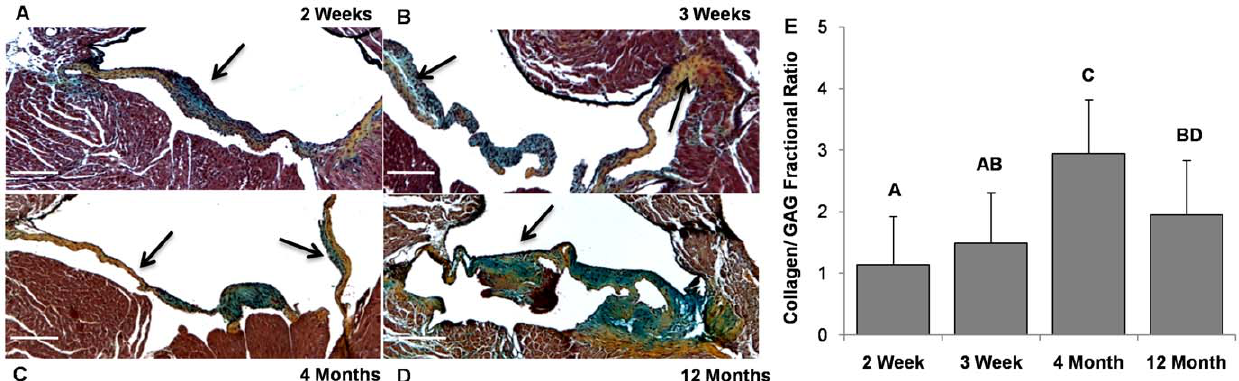
Figure 4. Temporal histological examination of C57/B6J mitral valves. (A) 2 week old murine mitral valves contain similar fractional amounts of collagen and GAGs, with the majority of collagen near the attachment zones but mostly undefined architecture (Movat’s stain: yellow/ orange=collagen, green/blue=GAGs). (B) More collagen relative to GAGs is present in 3 week old MV, with matrix stratification developing (Arrows). (C) At 4 months, murine mitral valves have nearly 3 times the amount of collagen to GAGs, are significantly more compact, and have well defined atrialis/fibrosa strata (Arrows). (D) At 12 months, murine mitral valves have significantly less collagen to GAGs, with dramatically increased thickening and reduced structural organization. (E) Digital quantification of matrix composition using color thresholding. Data compared as the ratio of collagen to GAGs within each valve leaflet. Magnification, 6 4. Scale bars: 200 m m. Error bars show 6 SD, n $ 3 valves per time point. Bars that do not share any letters are significantly different according to a one-way ANOVA with Tukey’s post hoc (p # 0.05).